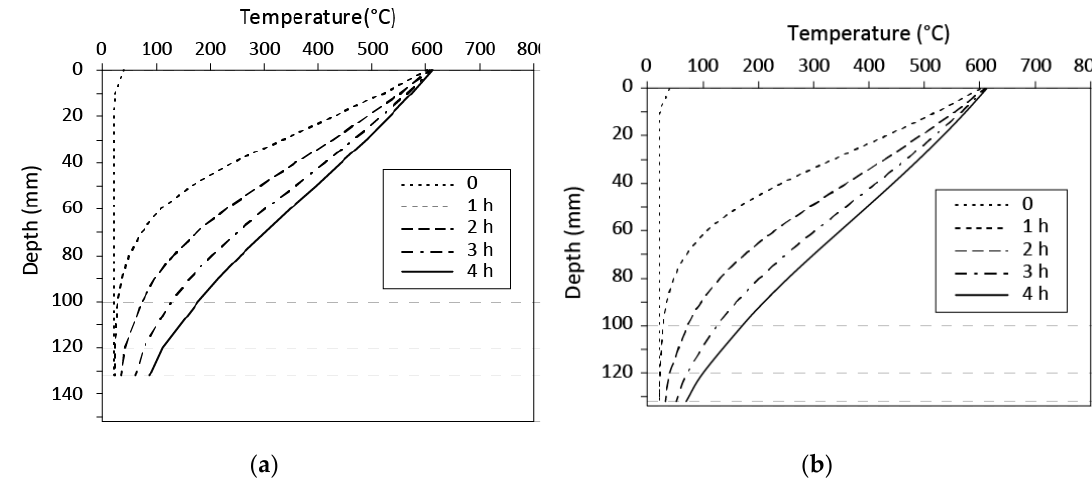
Buildings 2018 , 8 , x FOR PEER REVIEW Figure 12. Temperature distribution in green roof assemblies: ( a ) With wooden deck; ( b ) with steel deck.